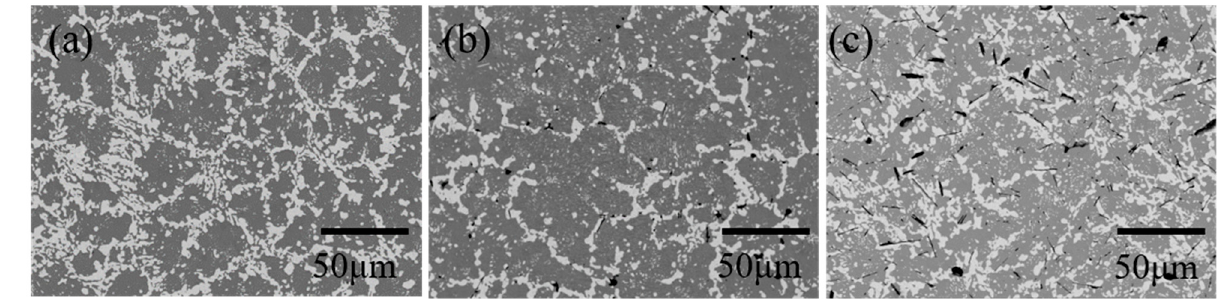
Figure 4. BSE images of ( a ) Sn-40Bi-0.1Zn, ( b ) Sn-40Bi-1.0Zn, and ( c ) Sn-40Bi-3.0Zn.